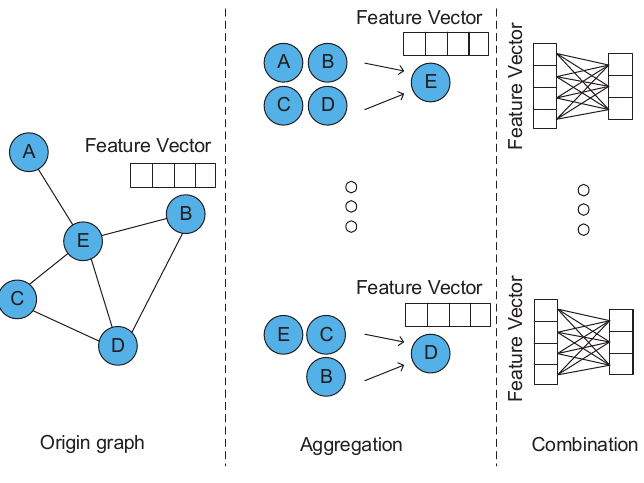
Figure 2. The calculation of most GCNs.